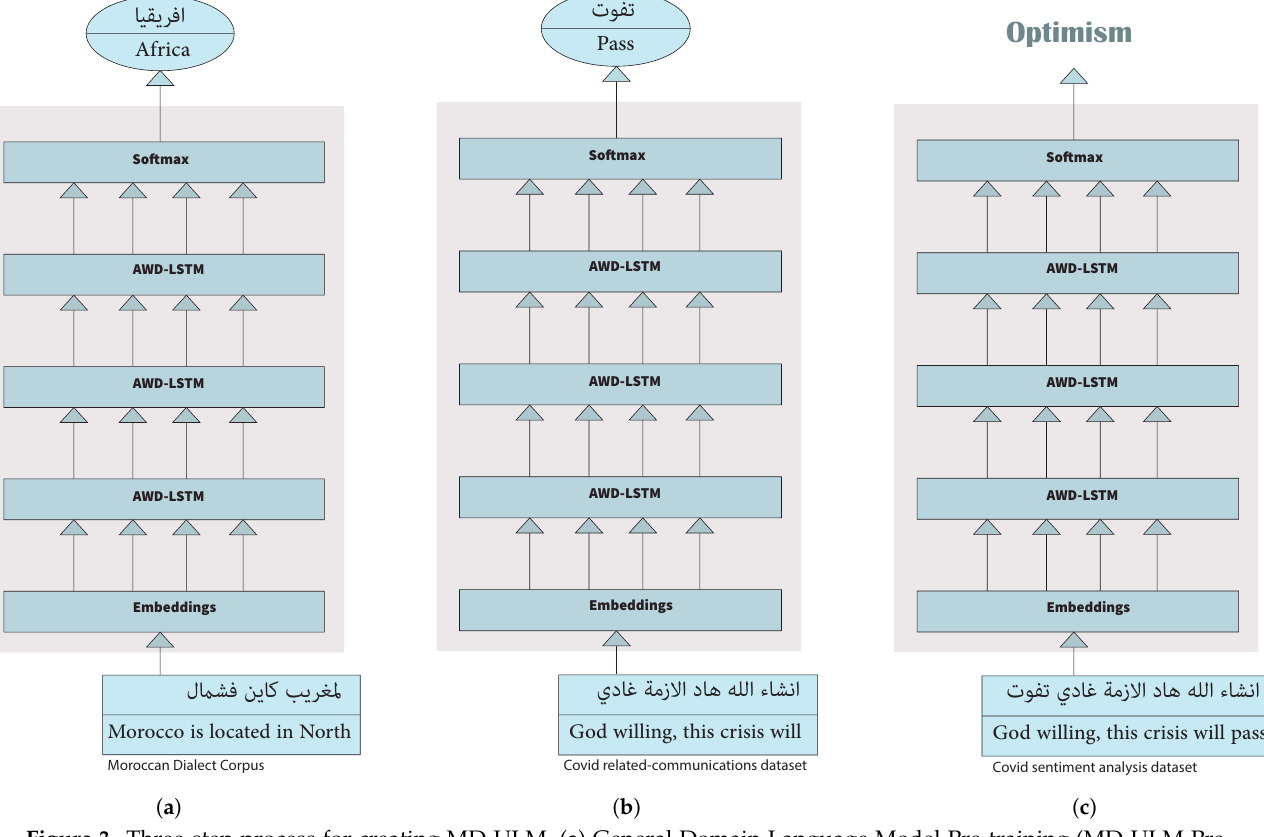
Figure 3. Three-step process for creating MD-ULM. ( a ) General Domain Language Model Pre-training (MD-ULM Pre- training). ( b ) Target Task Language Model Fine-tuning (MD-ULM fine-tuning). ( c ) Target Task